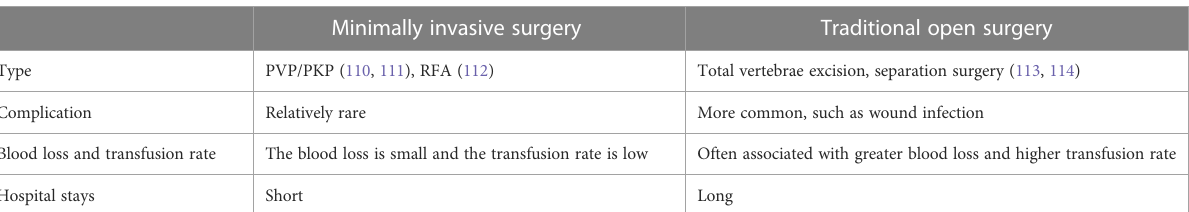
TABLE 2 Comparison of characteristics of minimally invasive surgery and traditional open surgery.